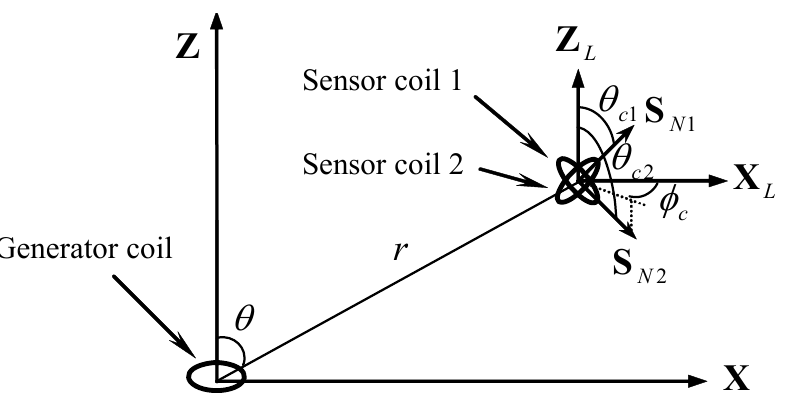
Figure 3. Illustration of the sensor module.